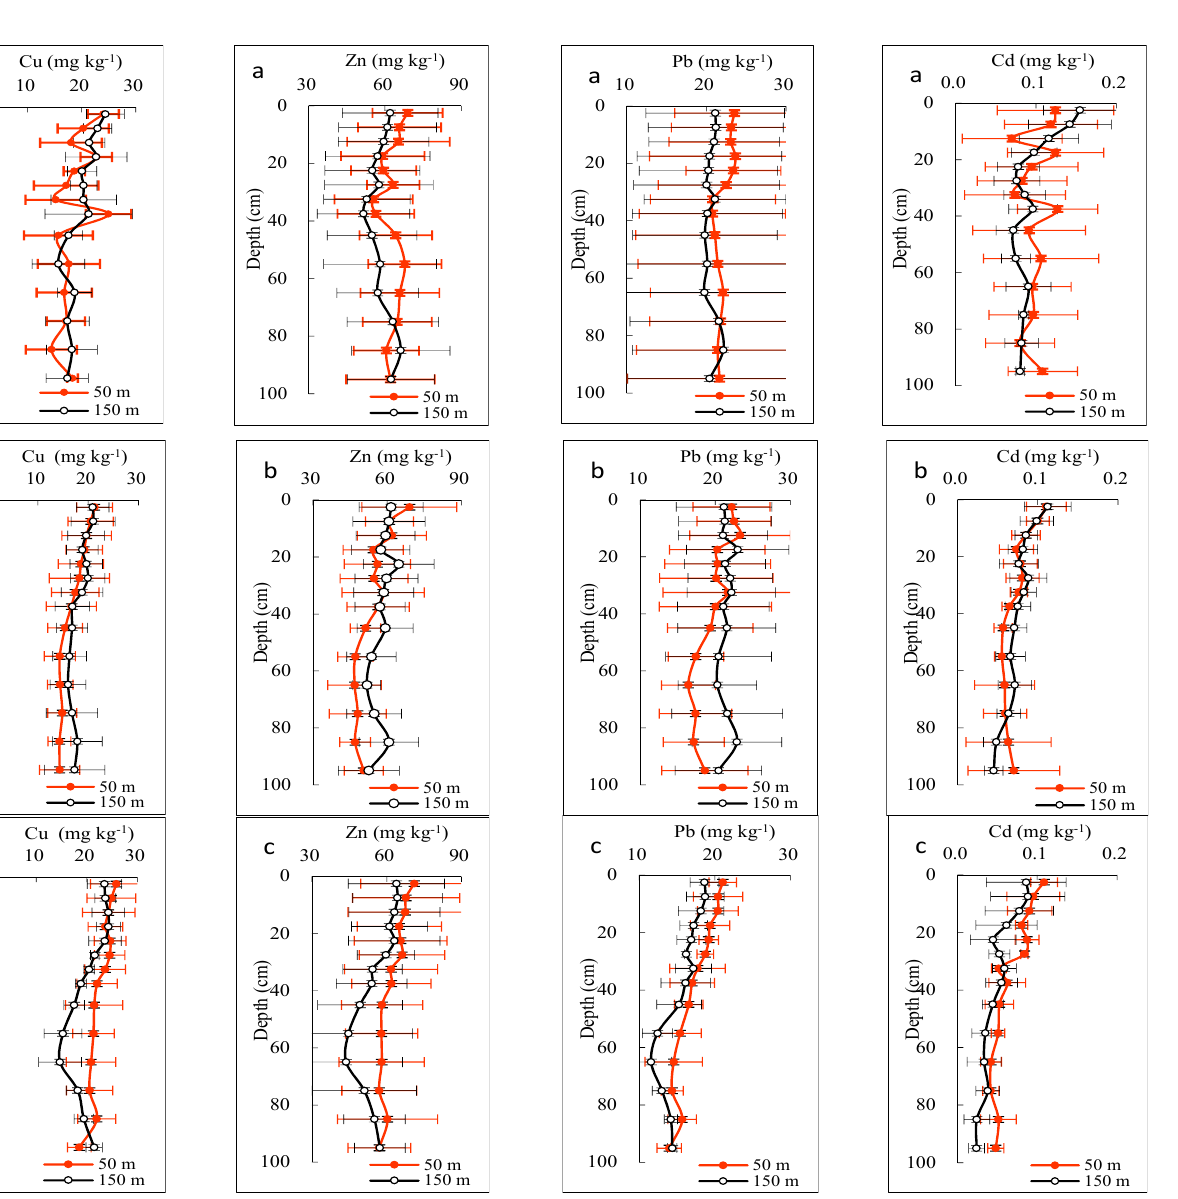
Figure 2. Vertical distributions of heavy metal concentrations for the average values and standard deviations (STD) in the vicinity of three highways: ( a ) Ningtong expressway; ( b ) Jinghu expressway; ( c ) Yanjiang expressway. The concentrations are the average values of repetitions. n = 3–4, the number of repetitions, as shown in Table 1.